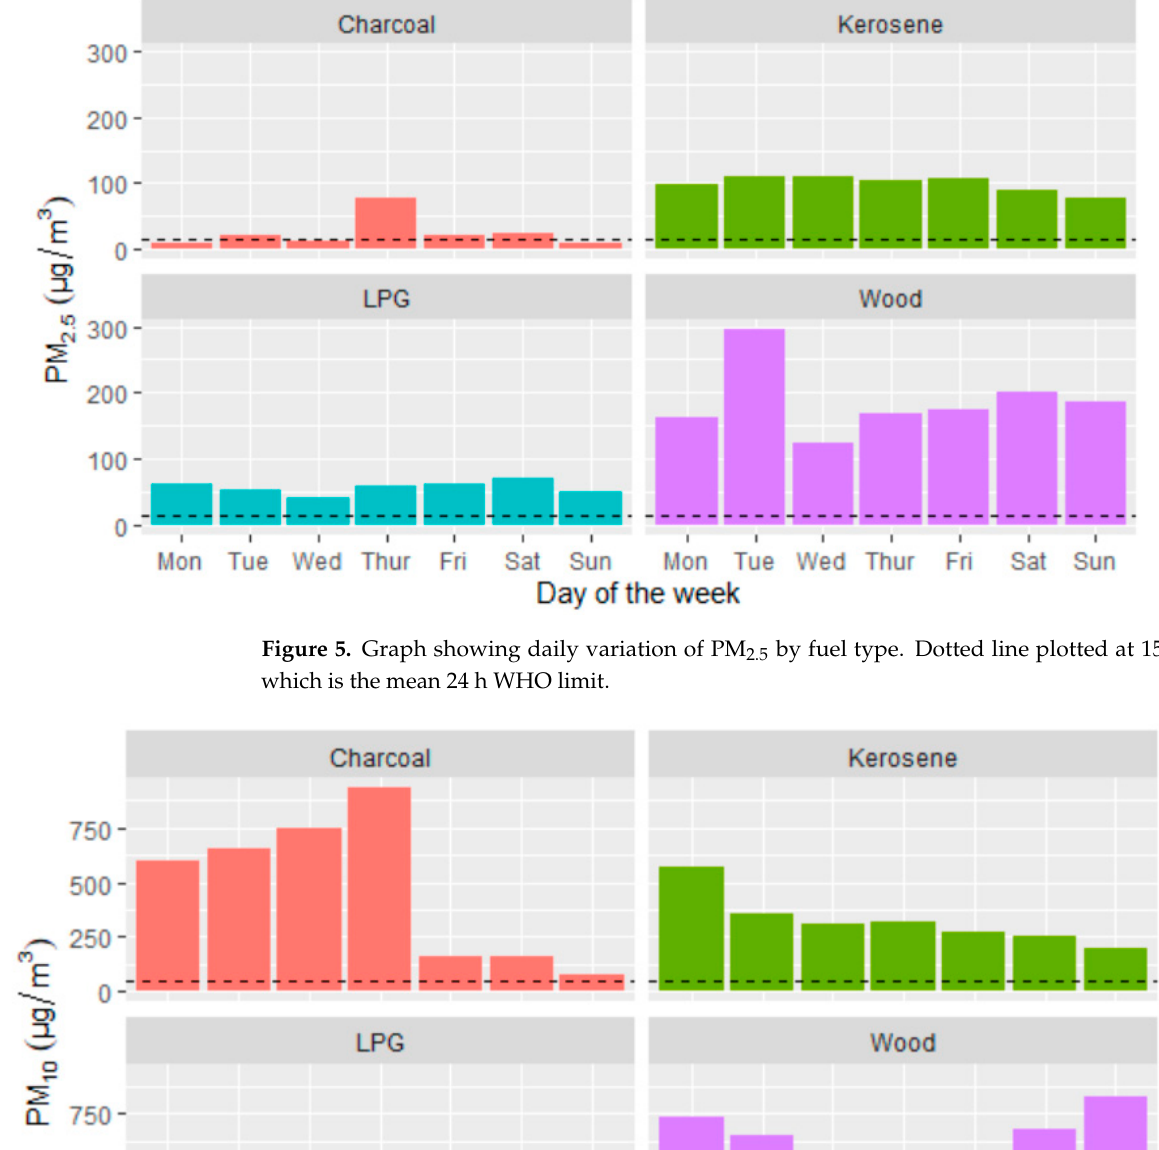
Figure 4. Graph showing hourly variation of PM 10 grouped by fuel type. Dotted line plotted at 45 µg/m 3 , which is the mean 24 h WHO limit.